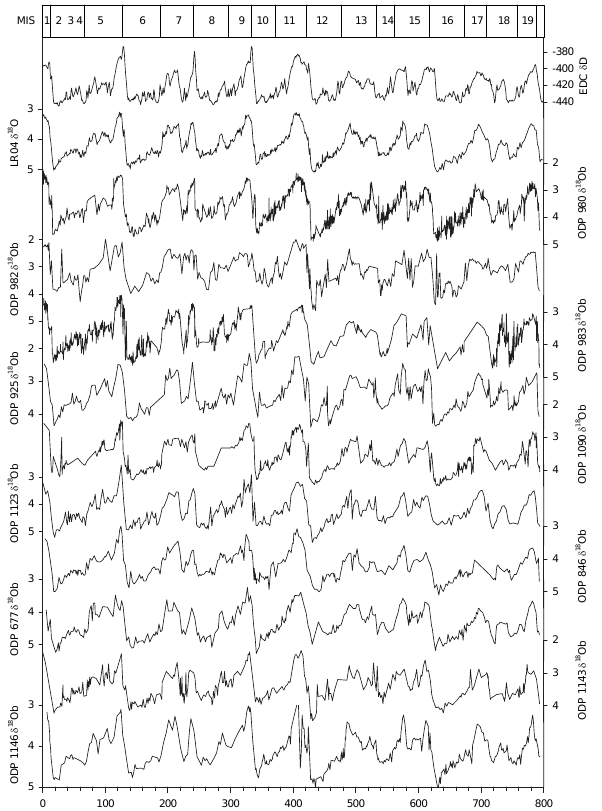
was constructed by orbitally tuning the record based on the correlation of peak BioSi %, which is likely controlled by the lake heat balance and thermal stratification (Prokopenko et al., 2001; Prokopenko et al., 2006), with September